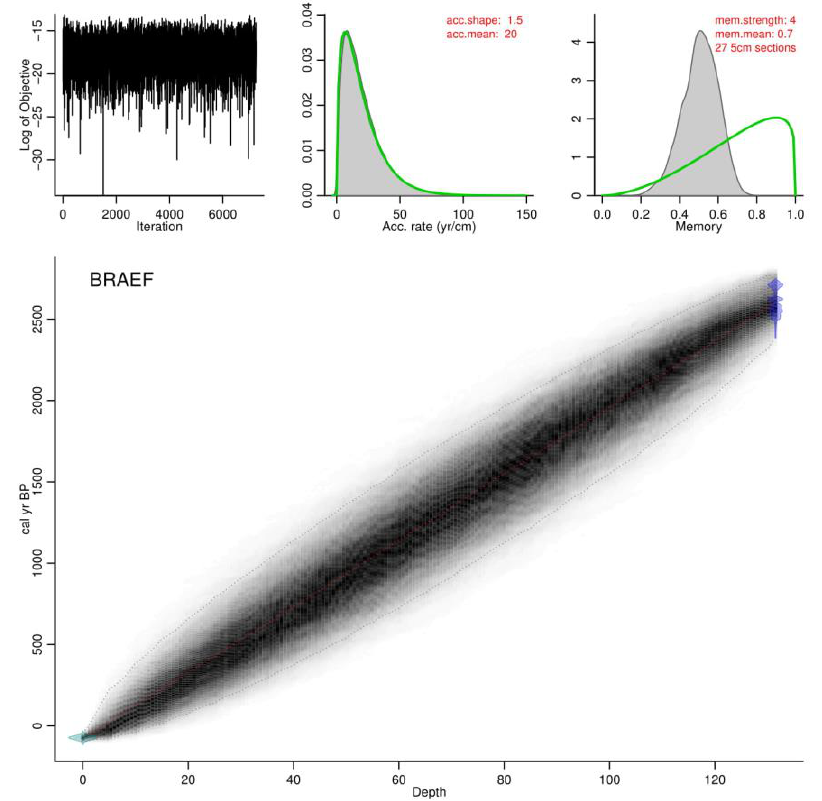
Figure A3c. Age-depth model produced in BACON for BRAEF.